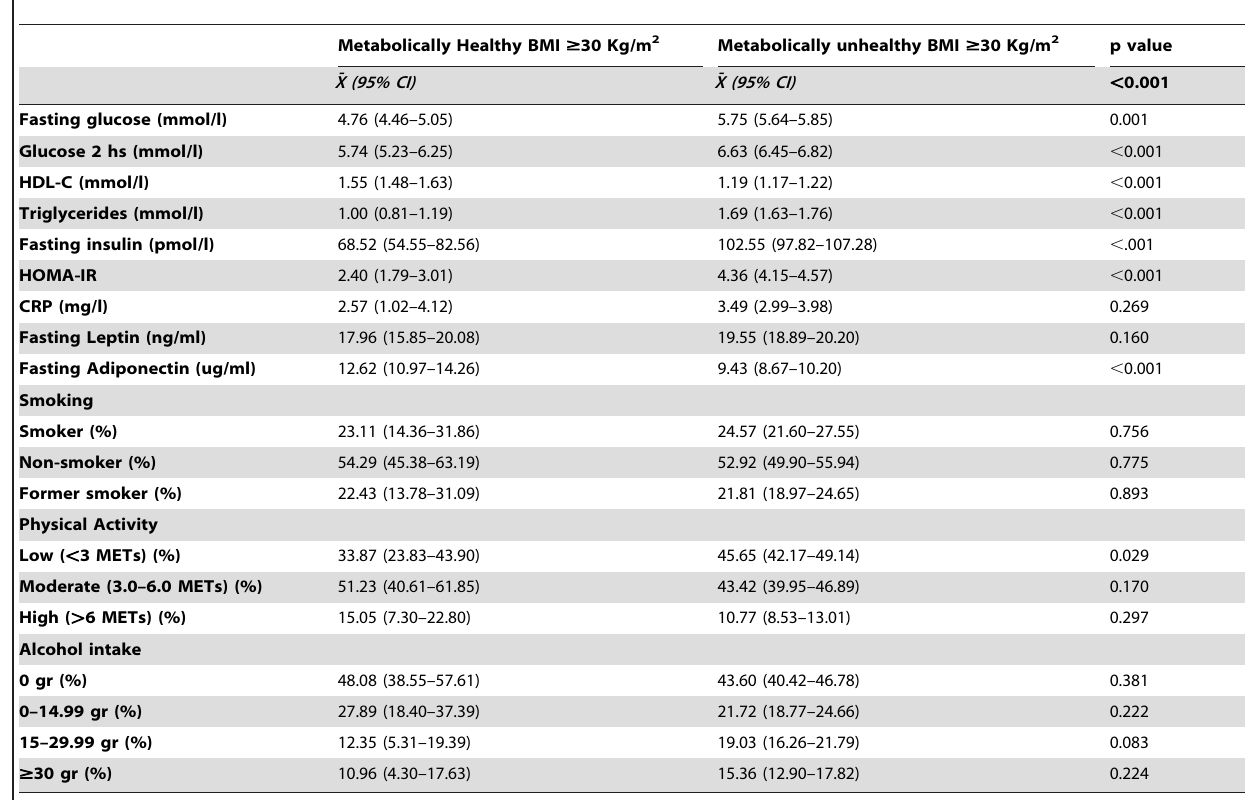
Table 5. Biochemical characteristics and lifestyle in individuals metabolically healthy and unhealthy with BMI $ 30 kg/m 2 by Wildman criteria, adjustment by age and